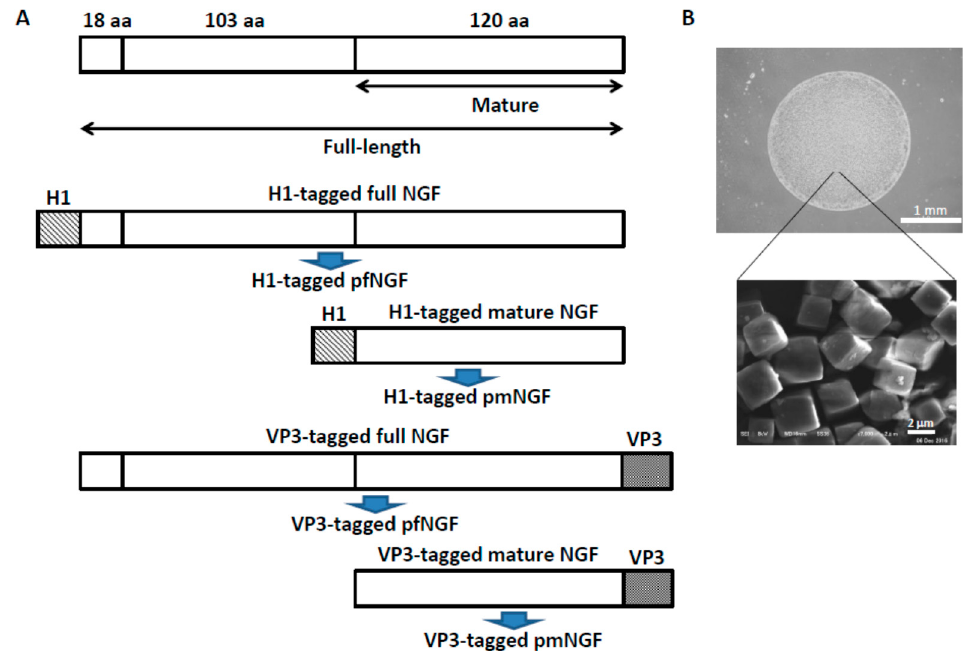
Figure 2. Construction and spotting of NGF-encapsulated protein nanoparticles. ( A ) Full-length and mature NGF (fNGF and mNGF, respectively) were fused with either a H1 or VP3 tag, and each recombinant NGF fusion protein was encapsulated into polyhedra to make H1-tagged or VP3-tagged pfNGF and H1-tagged or VP3-tagged pmNGF, respectively. ( B ) A spot of pNGF and SEM image of